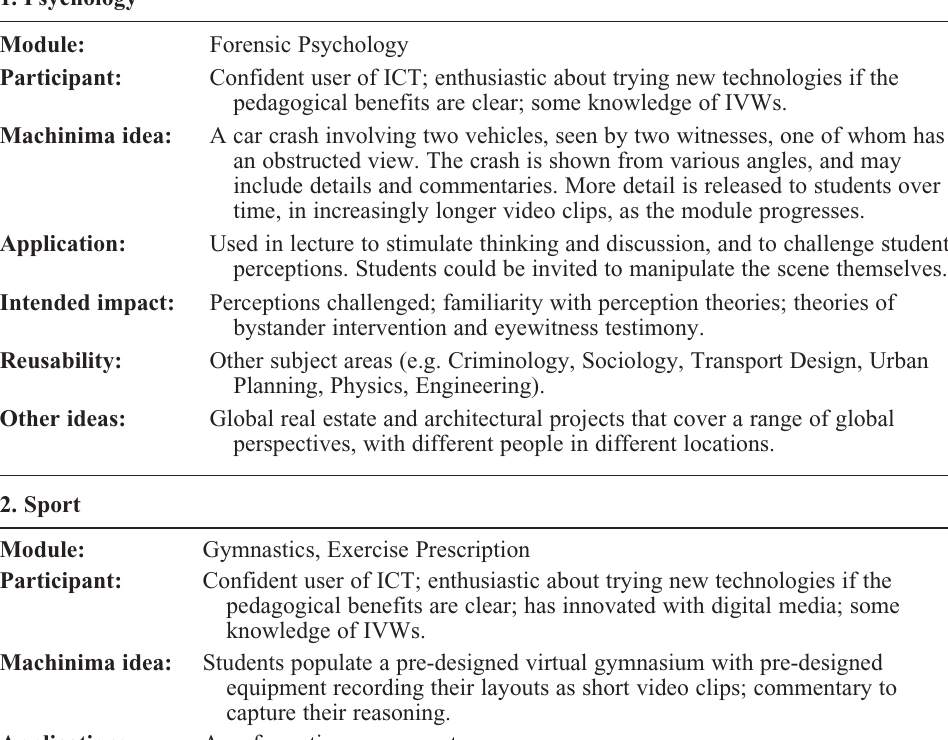
Table 1. Case study